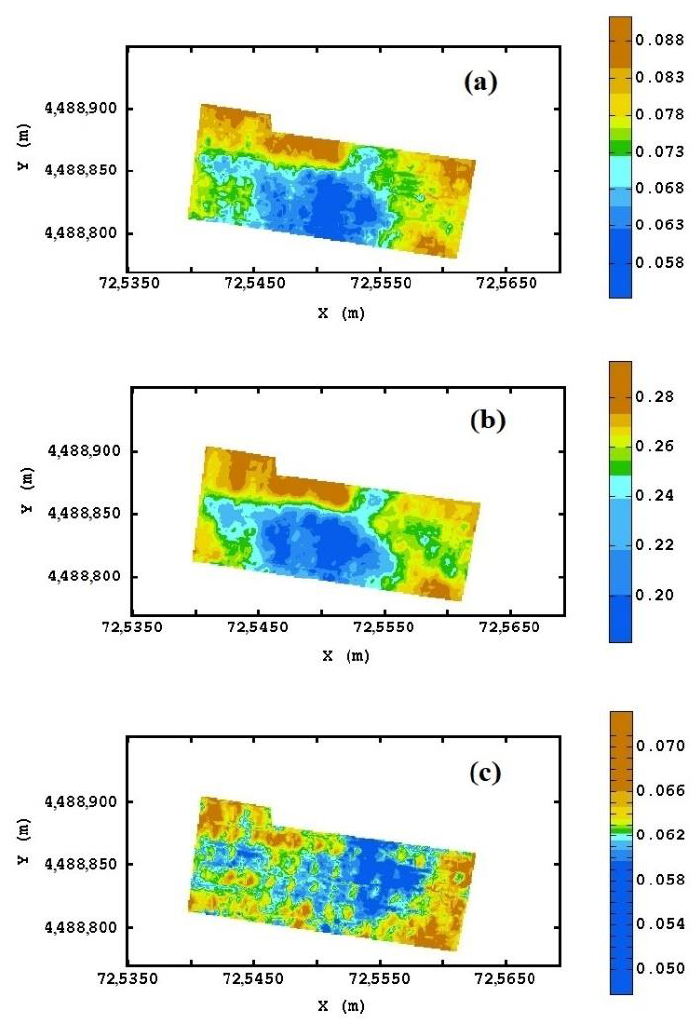
Figure 10. The maps of D1400 ( a ), D1900 ( b ) and D2200 ( c ). Colour scale uses isofrequency classes.